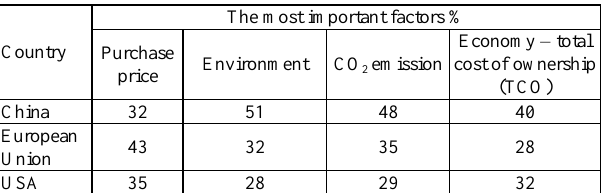
Table 1. Car preferences of users taken into account when buying a car, in % response to factor